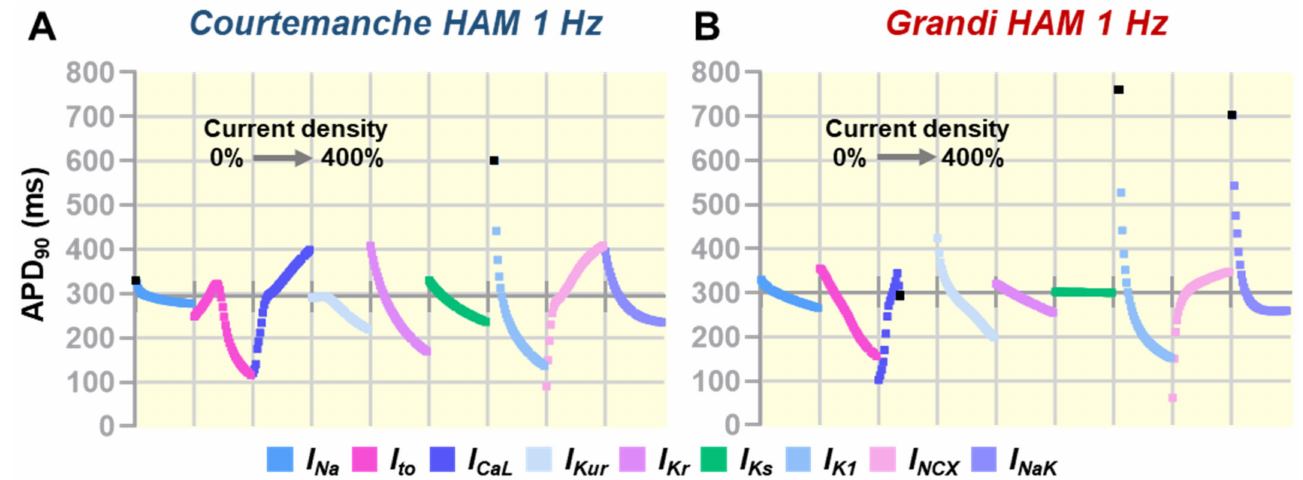
Figure 1. ( A , B ) The effect of G max perturbations (0% to 400%) on APD 90 between models. Each segment on the horizontal axes corresponds to a range of perturbations. Traces were discontinued (marked as black squares) when no APD 90 could be measured (e.g., repolarization failure/plateau arrest). The position of the horizontal axes indicates the baseline APD 90 for each model (100% G max